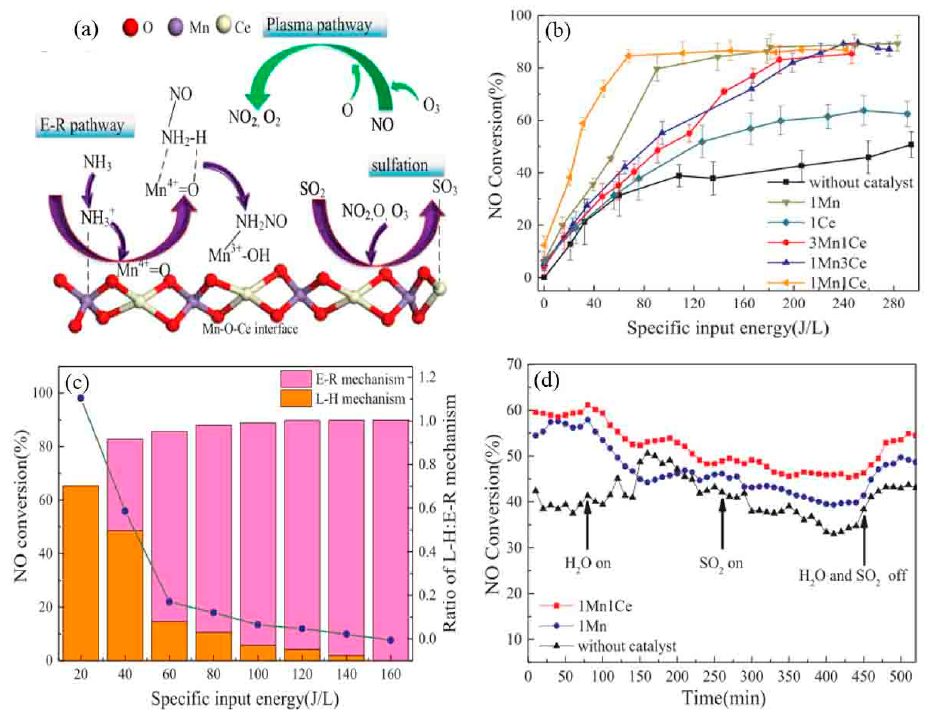
Figure 16. ( a ) Mechanism of NO x removal by plasma-modified catalyst Mn–Ce/ZSM5, ( b ) effect of different Mn–Ce ratios and plasma treatment on NO conversion, ( c ) denitrification process of catalyst Mn 1 Ce 1 /ZSM5 conforms to Eley–Rideal mechanism, and ( d ) study on sulfur and water resistance of plasma-modified catalyst [252]. Reproduced from Ref. [252], Copyright 2018, Elsevier.